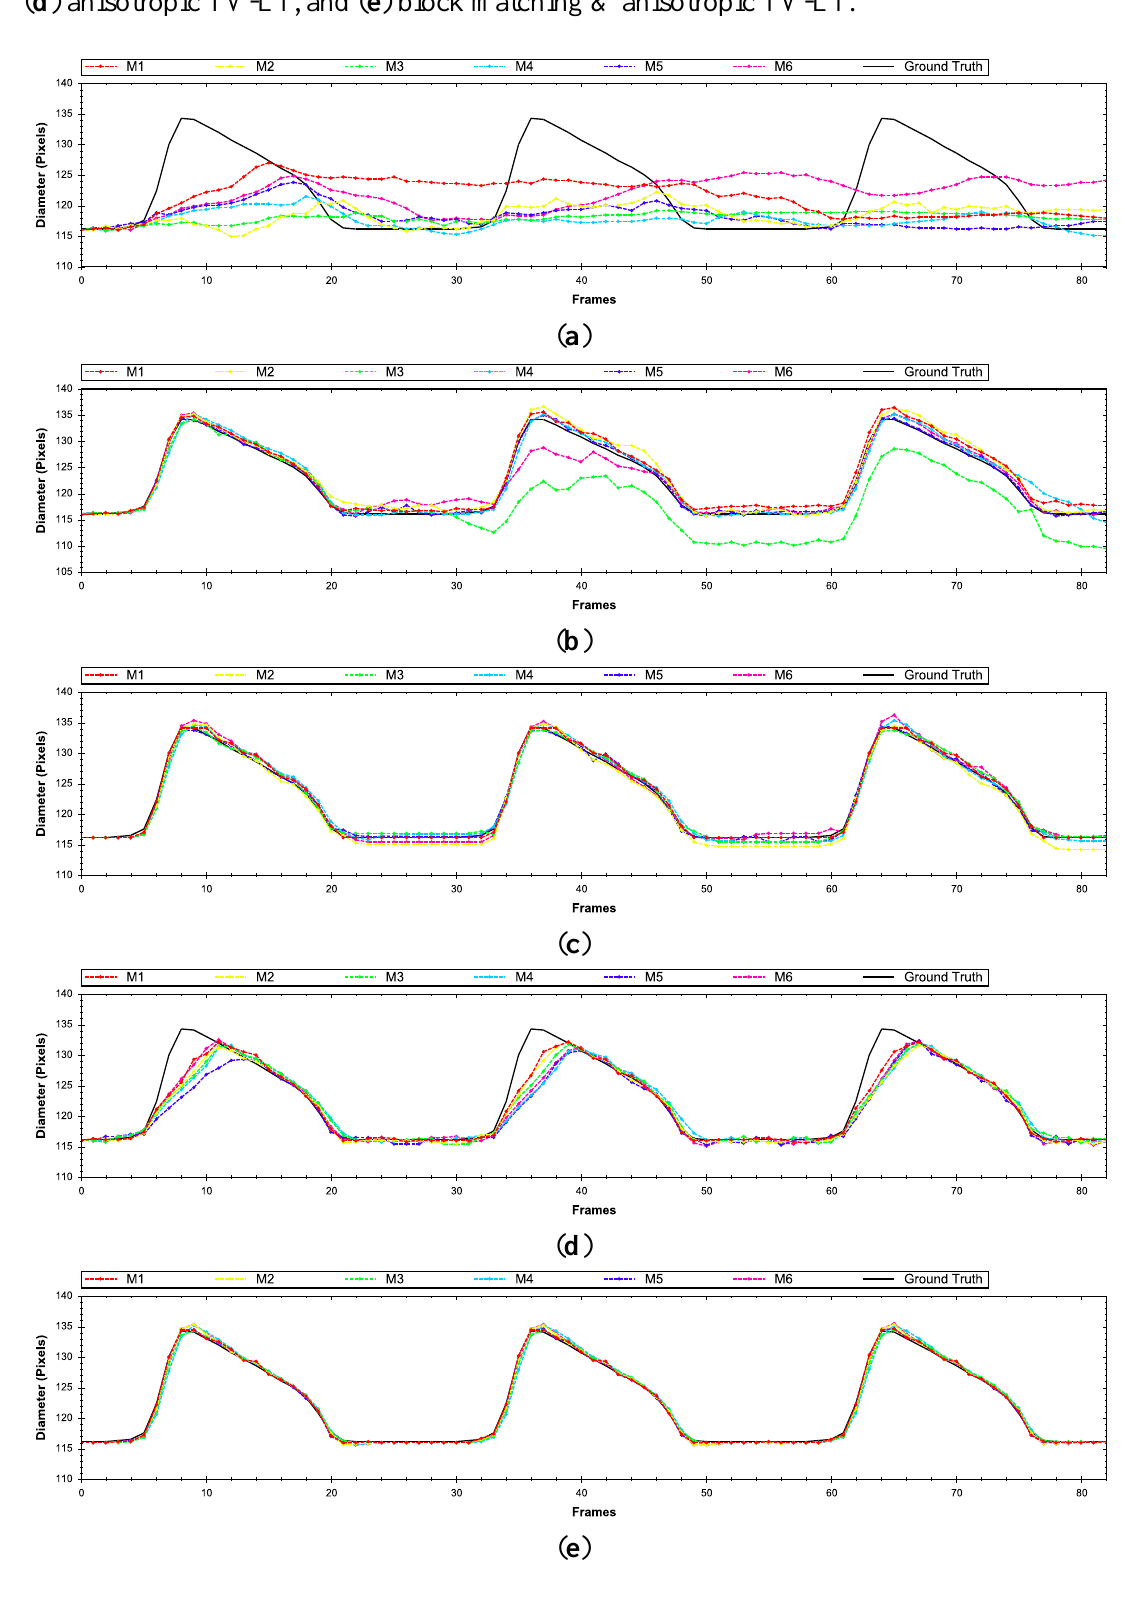
Figure 11. Diameter evolution over time evaluated in a sequence with long displacements using ( a ) Lucas-Kanade, ( b ) block matching & Lucas-Kanade, ( c ) block matching, ( d ) anisotropic TV-L1, and ( e ) block matching & anisotropic